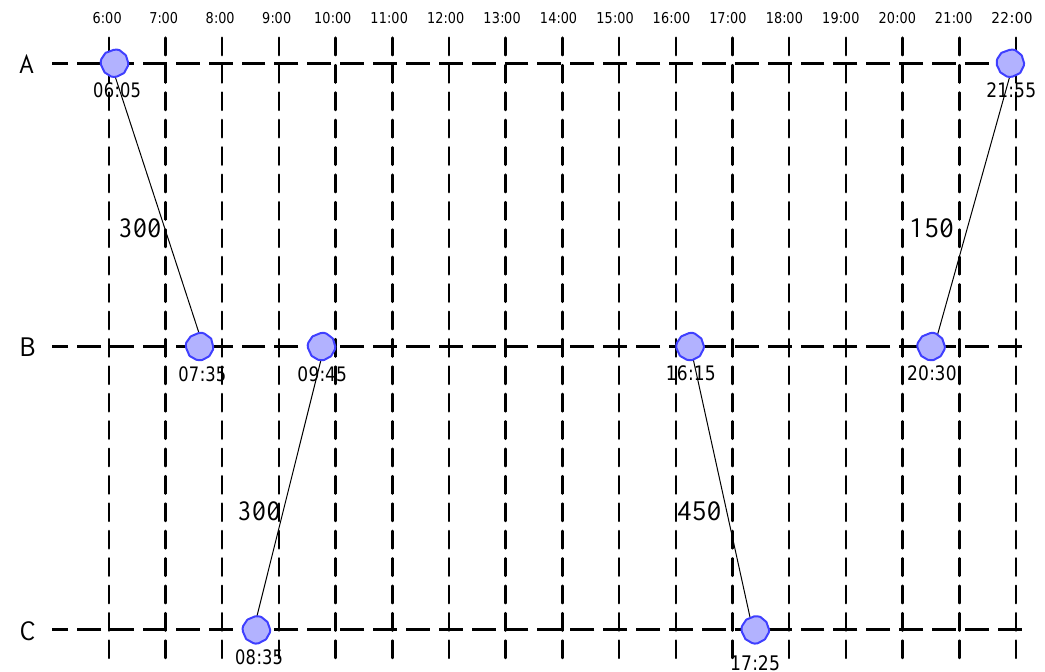
Figure 3. Time-line network for the illustrative